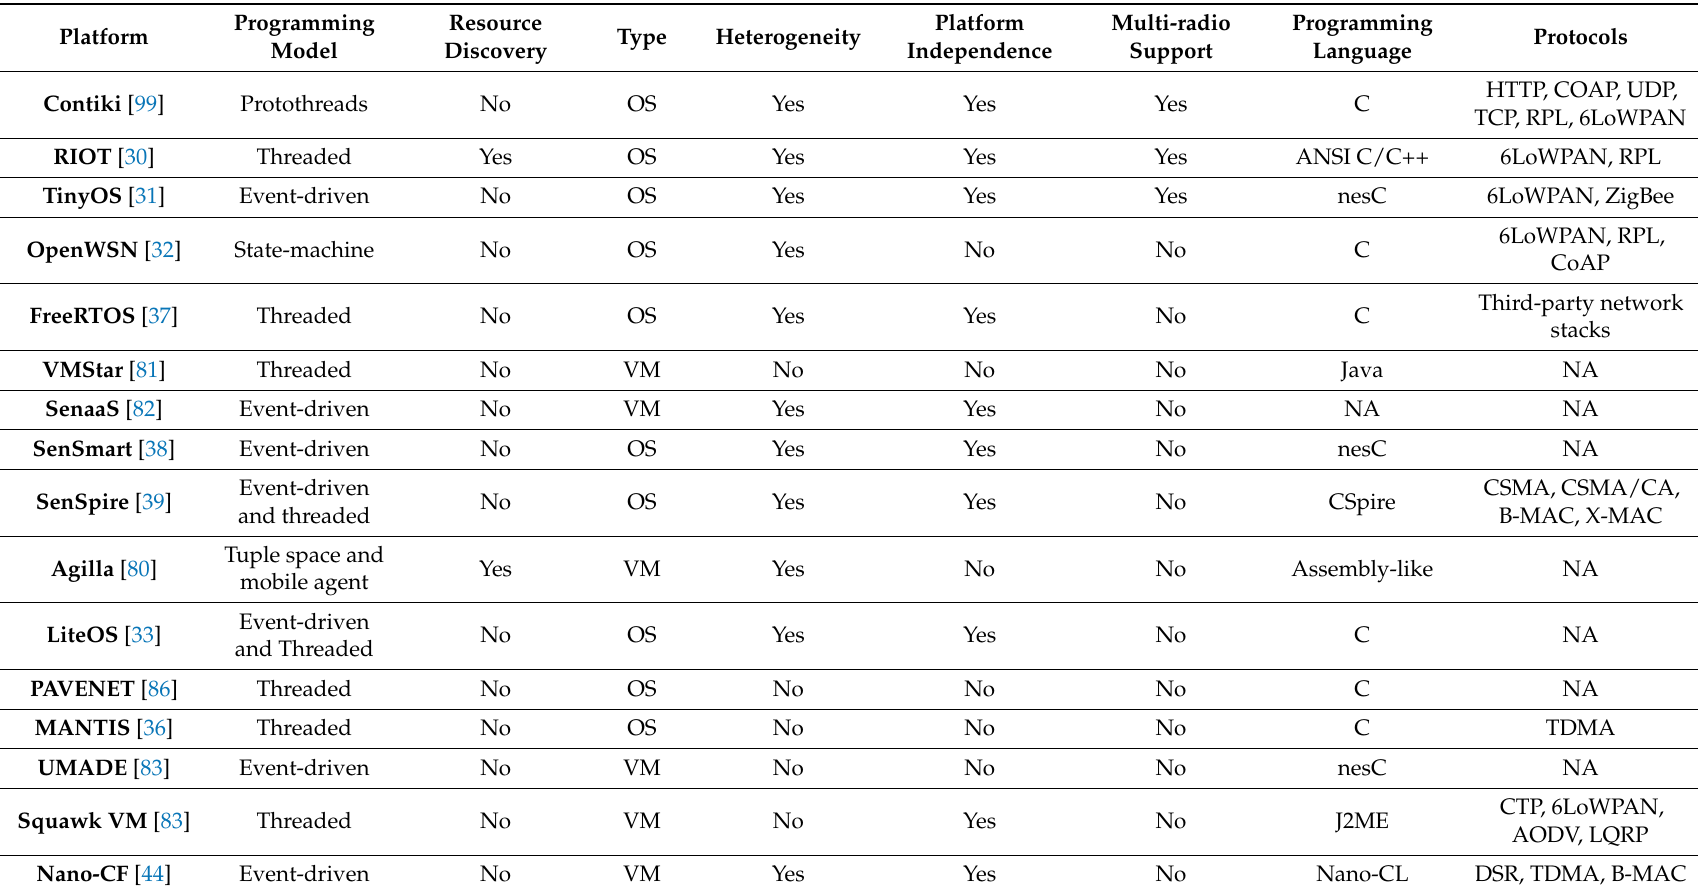
Table 3. A comparison of different virtualization